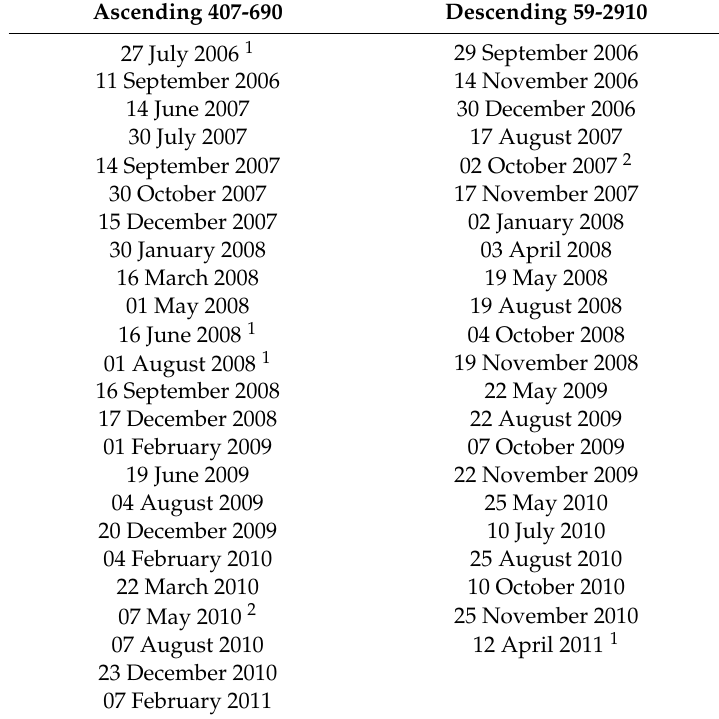
Table 1. Observation dates of scenes used for the interferometric synthetic aperture radar (InSAR) analysis in this